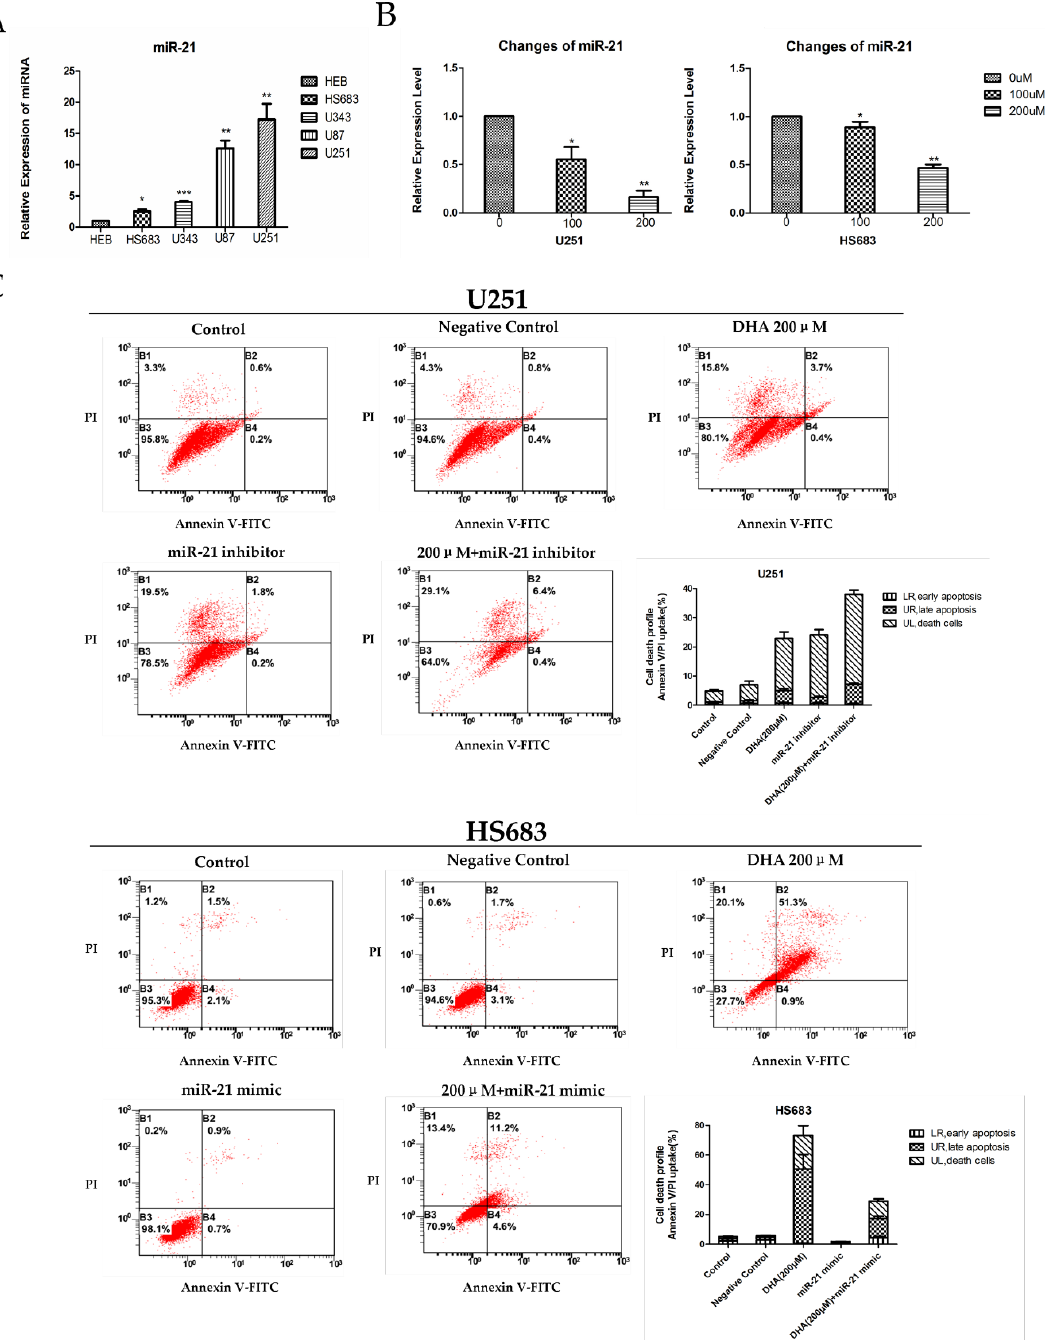
Figure 3. Effect of DHA on malignant glioma cells death by downregulating miR-21. ( A ) Relative expression of miR-21 in normal human glial cell line (HEB) and malignant glioma cells. Values were mean ± SD ( n = 3), * p < 0.05, ** p < 0.01, *** p < 0.001 as compared with negative control cells; ( B ) DHA downregulated miR-21 in malignant glioma cells (U251 and HS683). Values were mean ± SD ( n = 3), * p < 0.05, ** p < 0.01 as compared with negative control cells; ( C ) malignant glioma cells (U251 and HS683) with different treatments assayed by AnnexinV/PI flow cytometry. Right lower and upper quadrant and left upper quadrant showed cell deaths. Values were mean ± SD ( n = 3).